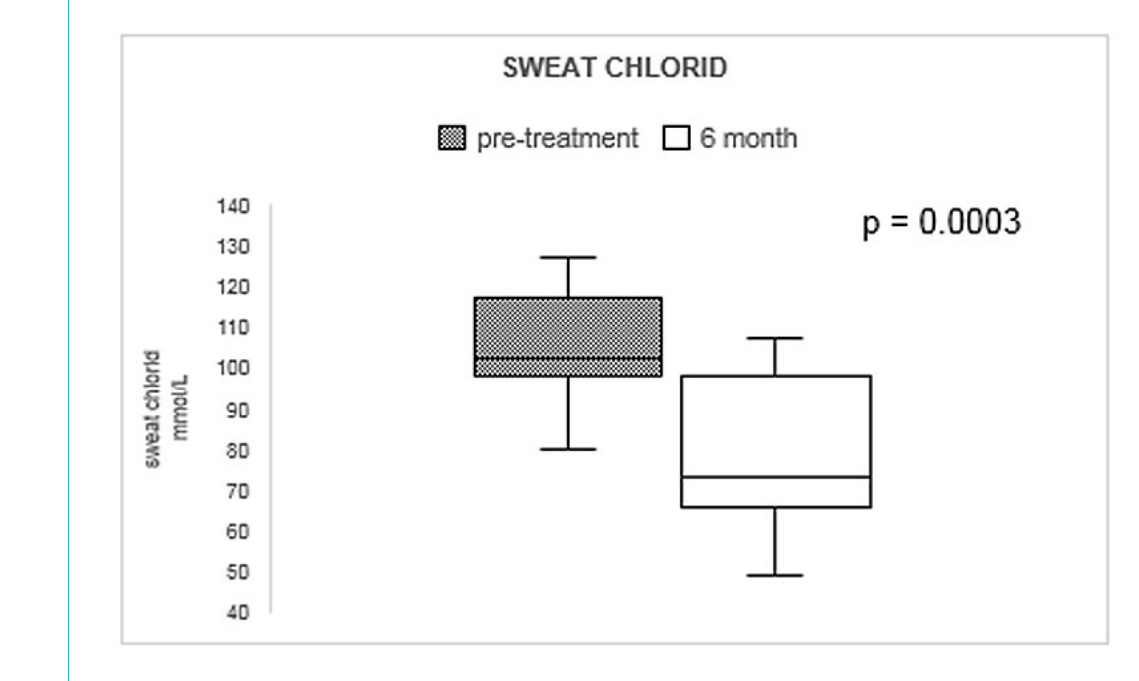
Figure 1: Change in sweat chloride from pre-treatment to 6 months of